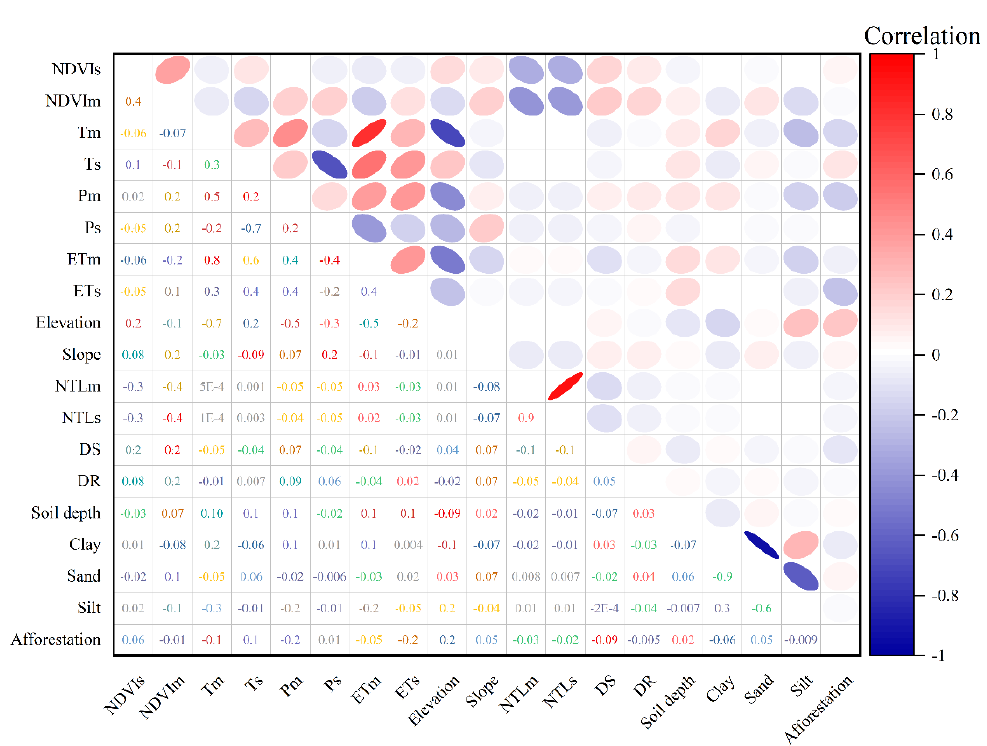
Figure 2. Correlation matrix showing the selected variables for forest restoration. Table 2. Discretization of the BBN model nodes.